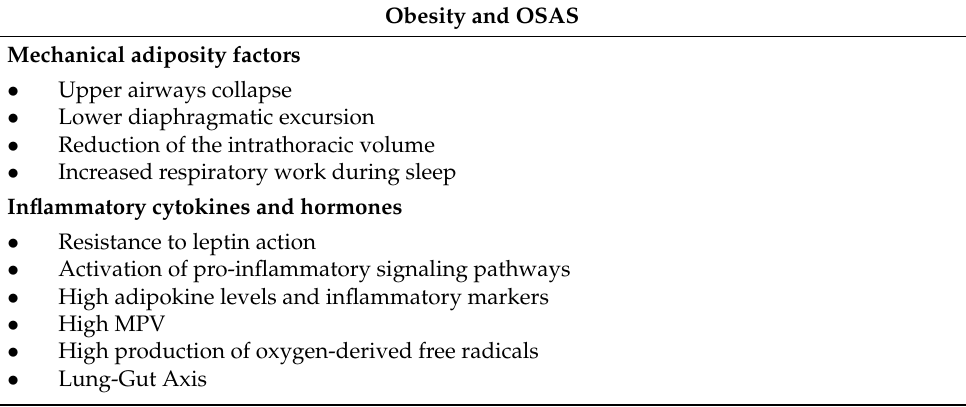
Table 2. The association between obesity and Obstructive Sleep Apnea Syndrome. Obesity and